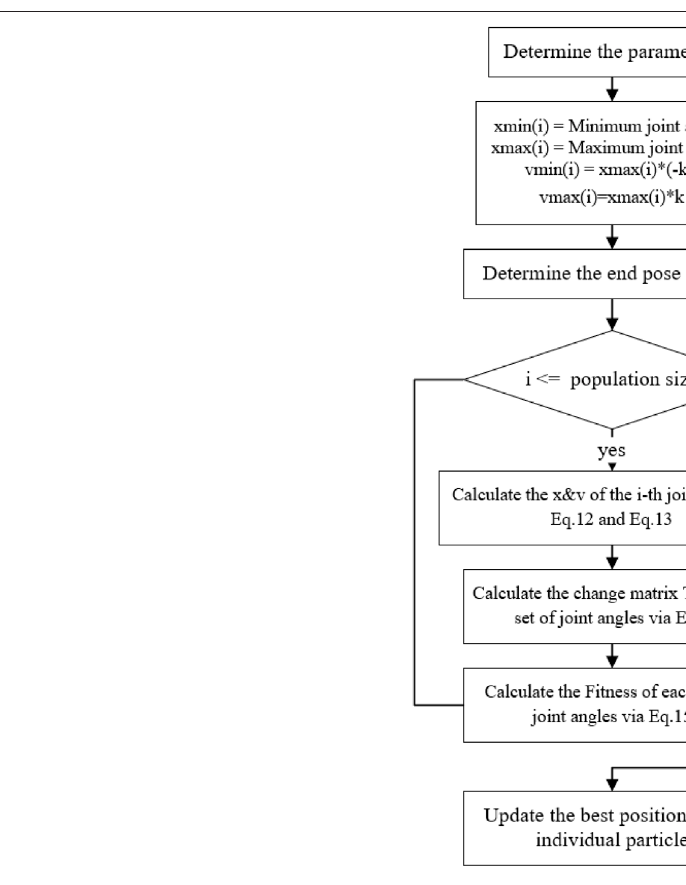
FIGURE 3 | Intialize